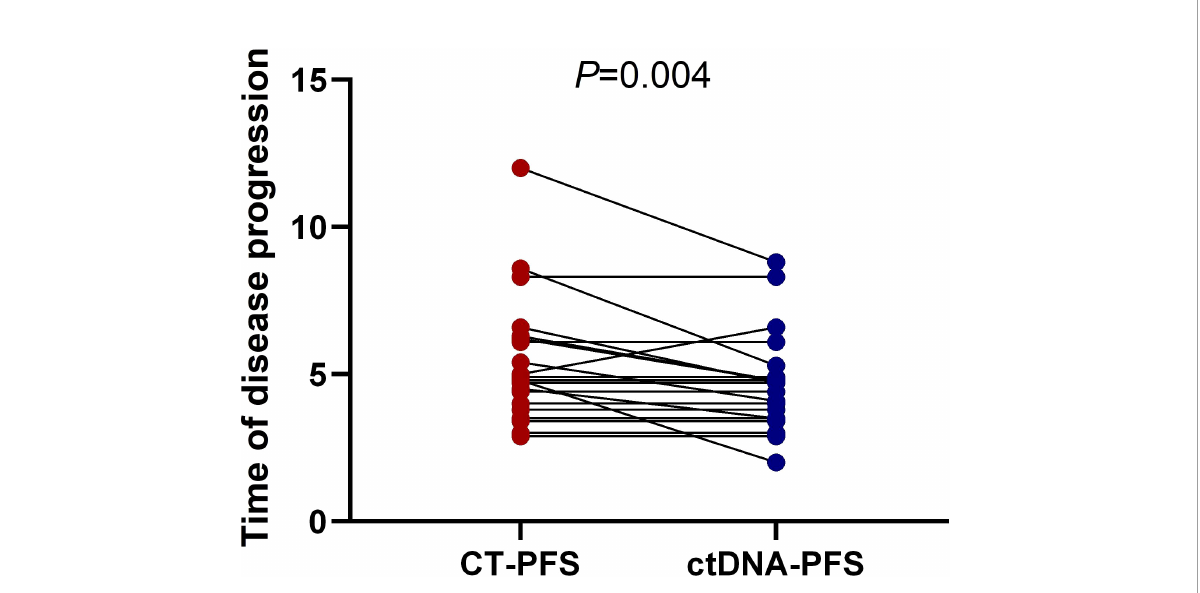
FIGURE 5 Longitudinal ctDNA analysis for disease progression monitoring. The comparison of the disease progression time measured by ctDNA versus CT (4.6month vs 5.5month, p = 0.004, two-sided Wilcoxon two-sample paired signed-rank test, p = 0.004). CT, computed tomography; PFS, progression-free survival; ctDNA, circulating tumor DNA.